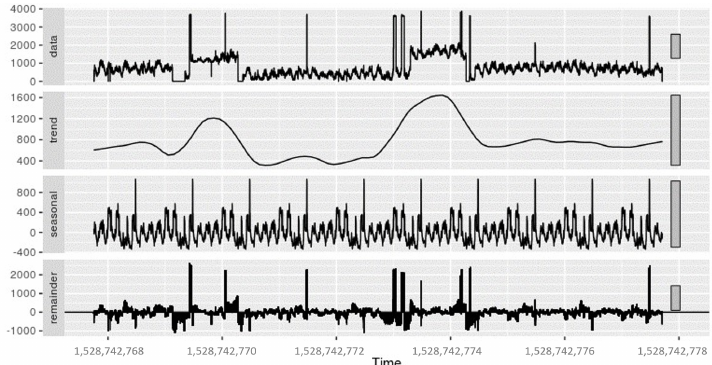
Figure 8. Armature Current—Time Series